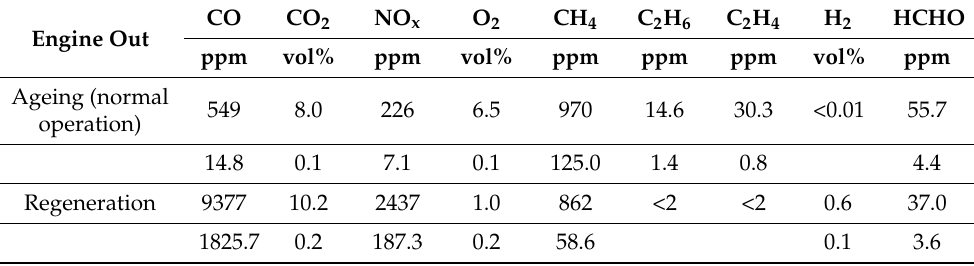
Table 1. Engine out exhaust gas composition (as measured in dry gas). In “Ageing”-mode hydro- carbons are measured by GC and others by Horiba, while in “Regeneration”-mode O 2 and H 2 were measured by GC and others by FTIR. HCHO was measured with FTIR.